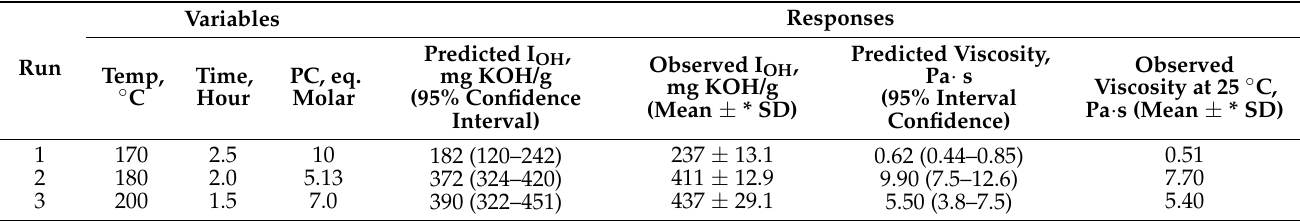
Table 4. Validation of the fitted model for I OH and